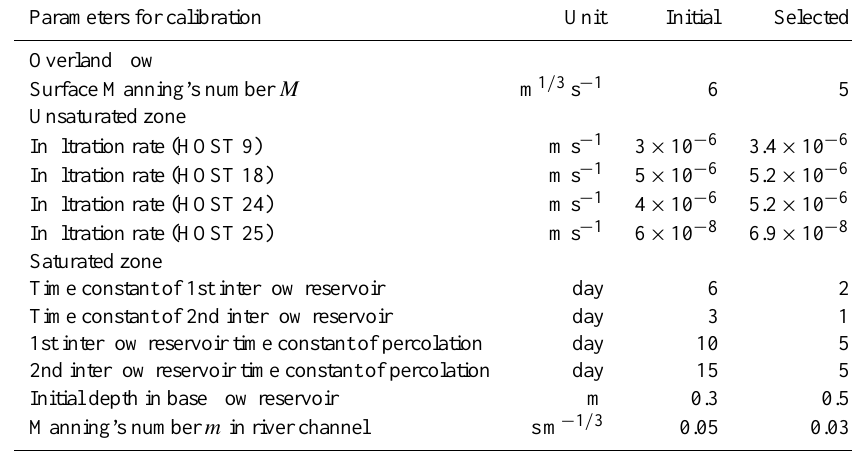
Table 1. Initial parameter values and expected ranges for MIKE SHE model.